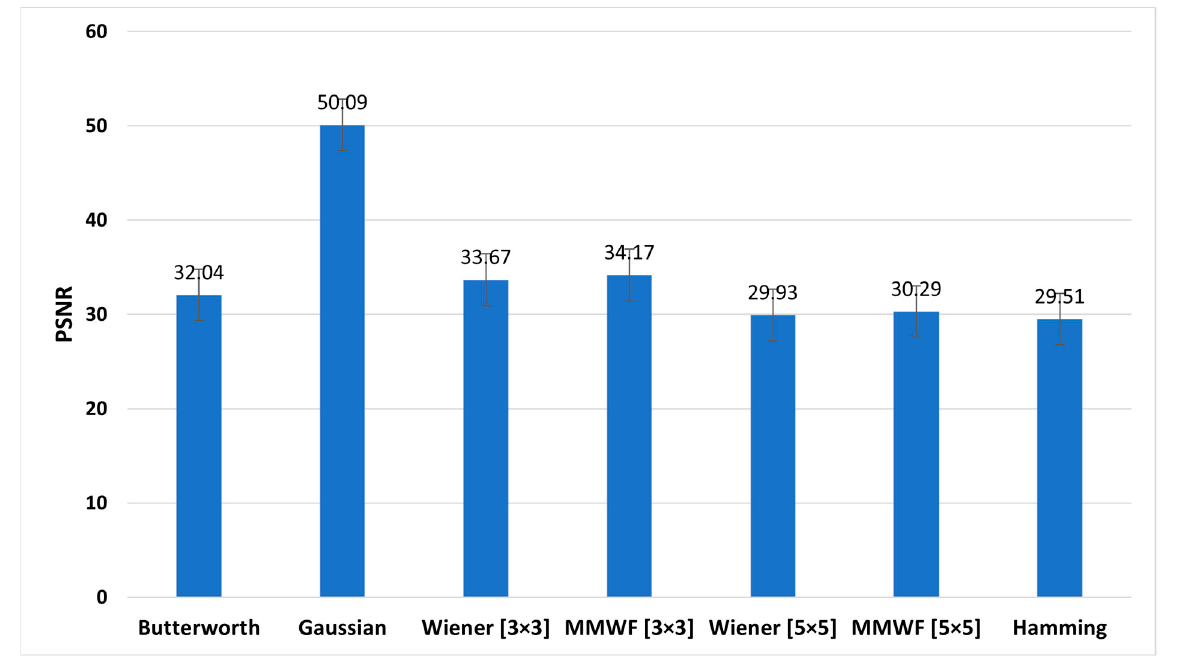
Figure 9. Comparison of the average peak signal-to-noise (PSNR) graph of different filters for the studied myocardial perfusion SPECT images.